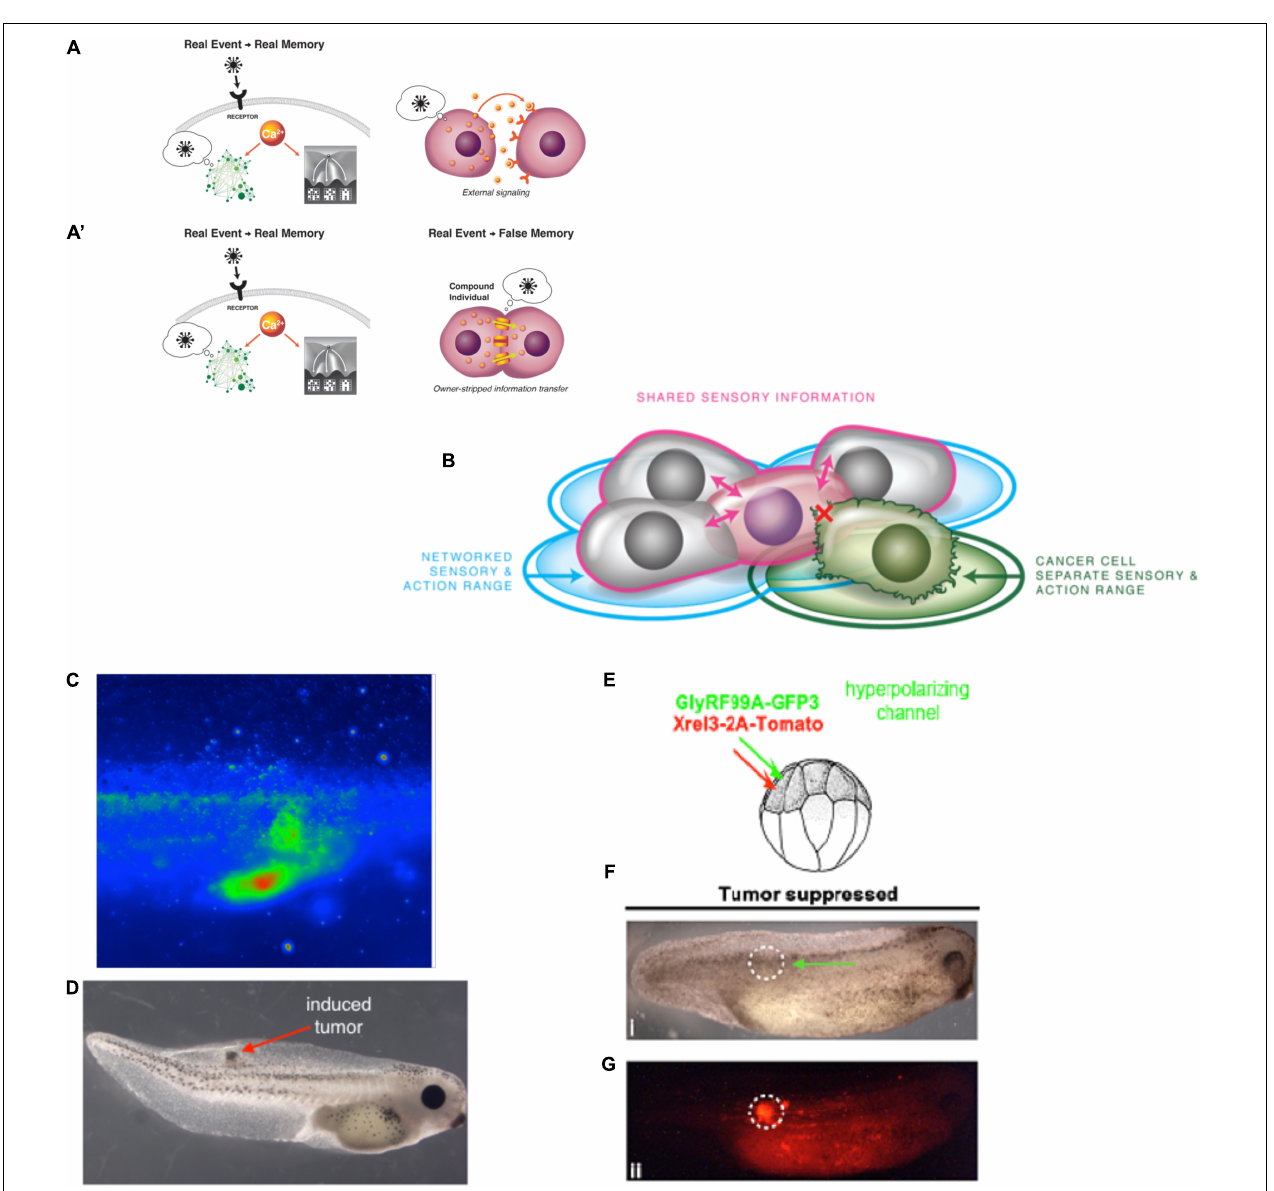
FIGURE 9 | Gap junctions and the cellular collective. Communication via diffusible and biomechanical signals can be sensed by receptors at the membrane as messages coming from the outside of a cell (A) . In contrast, cells coupled by gap junctions enable signals to pass directly from one cell’s internal milieu into another. This forms a partial syncytium which helps erase informational boundaries between cells, as memory molecules (results of pathway dynamics) propagate across such cell groups without metadata on which cell originated them. The versatile gating of GJ synapses allows the formation of multicellular Selves that own memories of physiological past events at the tissue level (not just individual cells’) and support larger target patterns, enabling them to cooperate to make complex organs (B) . This process can break down: when oncogenes are expressed in tadpoles, voltage dye imaging (C) reveals the abnormal voltage state of cells that are disconnected bioelectrically from their neighbors, reverting to an ancient unicellular state (metastasis) that treats the rest of the body as external environment and grows out of control as tumors (D) . This process can be prevented (Chernet and Levin, 2013a,b; Chernet et al., 2016) by artificially regulating their bioelectric state [e.g., co-injecting a hyperpolarizing channel with the oncogene, (E) ]. In this case the tissue forms normally [ (F) , green arrow], despite the very strong presence of the oncogene [ (G) , red label]. This illustrates the instructive capacity of bioelectric networks to dominate single cell and genetic states to control large-scale